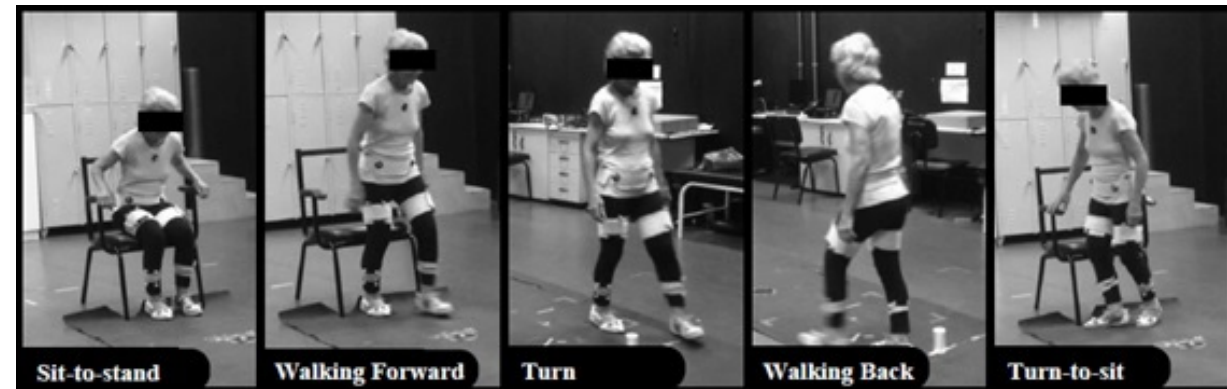
Figure 1. Performance on the subtasks of the timed up and go test in the Qualysis Pro Reflex